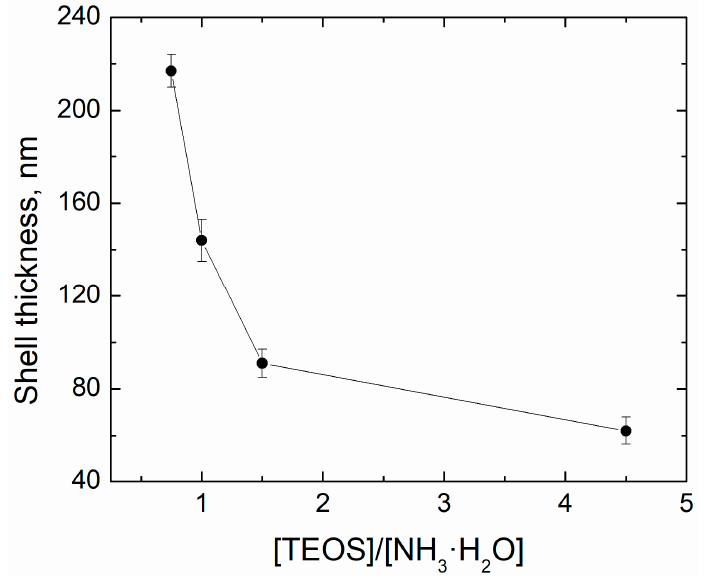
Figure 9. The thickness of the shell of the Fe@SiO 2 filler varied through ammonia concentration thickness of the shell vs. [TEOS]/[NH 3 · H 2 O] ratio.